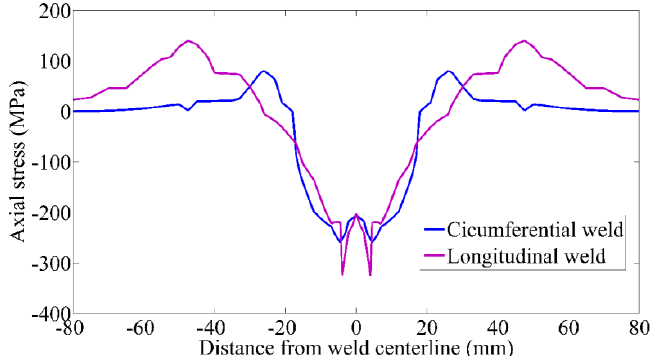
Fig. 13. Residual axial stress distribution on the outer surface for circumferential and longitudinal weld butt